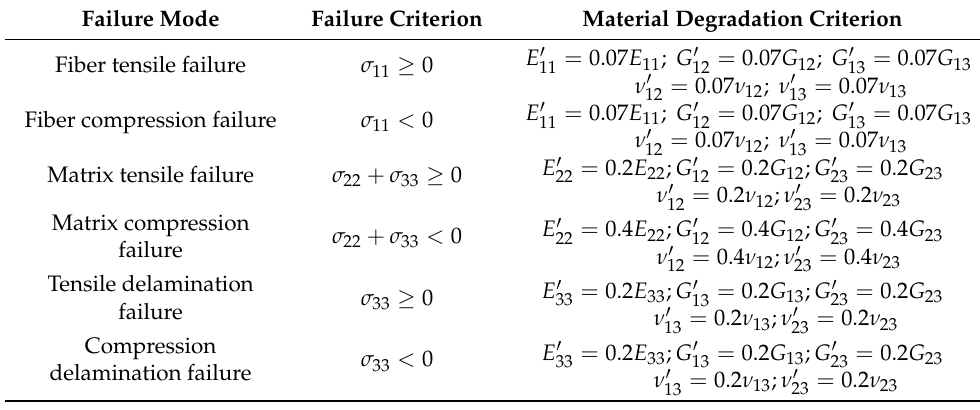
Table 2. Degradation rules for the material properties used in the